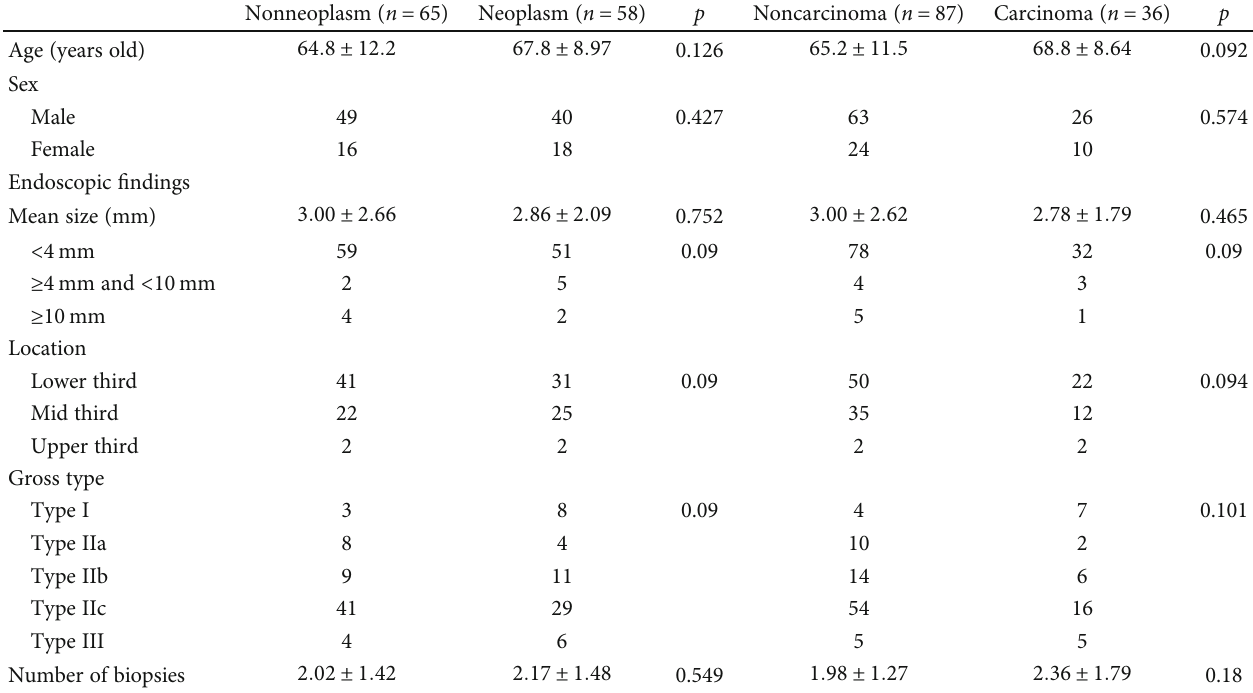
Table 2: Clinical and endoscopic features according to fi nal diagnosis.